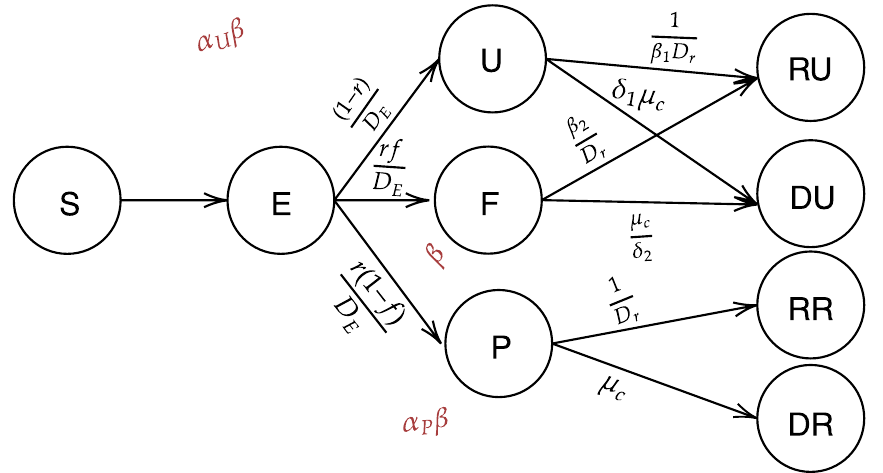
Figure 2. Diagram describing model compartments and transmissions for the extended SEIR model. For the detailed descriptions of the compartments and parameters, please refer to Supplementary Table 2 and the “Methods”